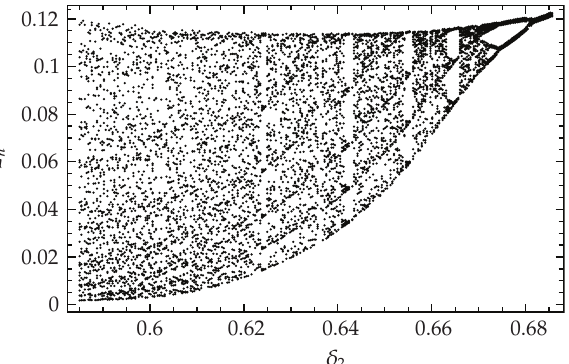
Figure 5: Bifurcation diagram for z n as a function of δ 2 , with (cid:3) (cid:7) 0 . 5 and δ 2 ∈ (cid:5) 0 . 585 , 0 . 686 (cid:5) .